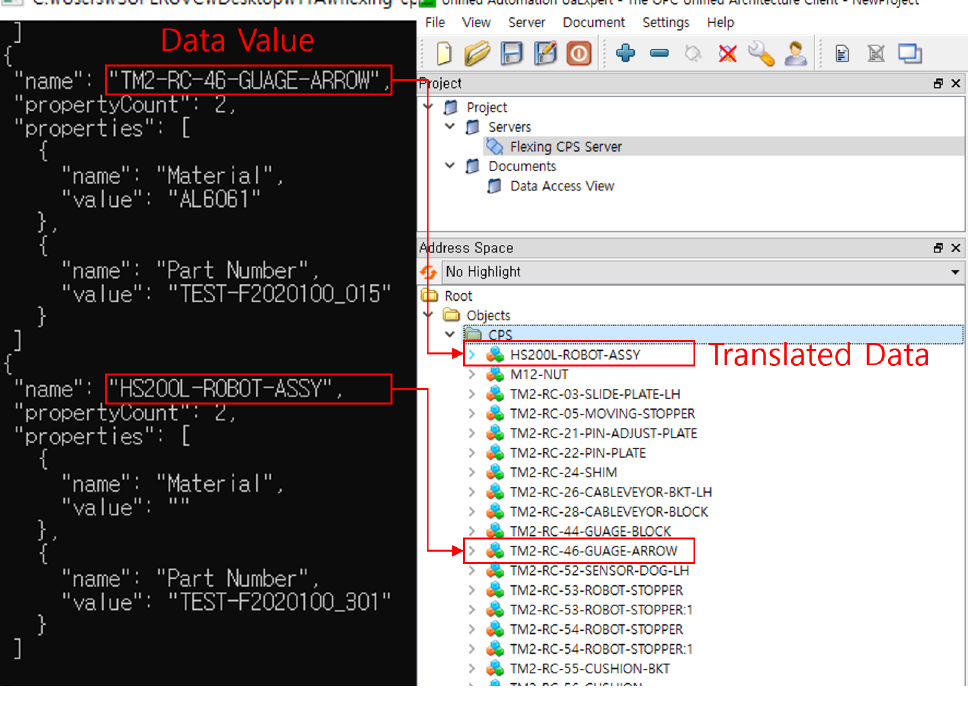
Figure 17. Data conversion of CPS server.